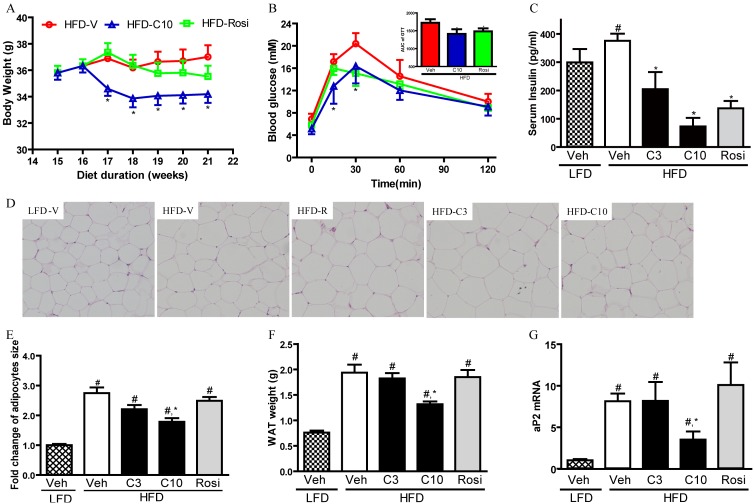
CMHX008 protects HFD induced obesity and insulin resistance.C57BL/6 mice were fed with HFD or LFD for 16 weeks. Then HFD fed C57BL/6 mice were treated with CMHX008 (3 and 10 mg/kg, HFD-C3 and HFD-C10), rosiglitazone (3 mg/kg, HFD-Rosi) or vehicle (HFD-Veh or LFD-Veh) only. After 4 weeks treatment, intra-peritoneal glucose tolerance tests (iGTTs) were performed (B) and area under curve (AUC) of iGTTs was calculated (B, inserted Figure). Changes in body weight (A), fasting insulin levels (C), morphology of adipocytes (D), quantified adipocyte size (E), mass of epididymal adipose tissues (WAT, F) and aP2 mRNA levels (G) were examined. Data are the means ± S.E.M., n = 6–8; #
P<0.05 vs LFD-Veh and *P<0.05 vs HFD-Veh.